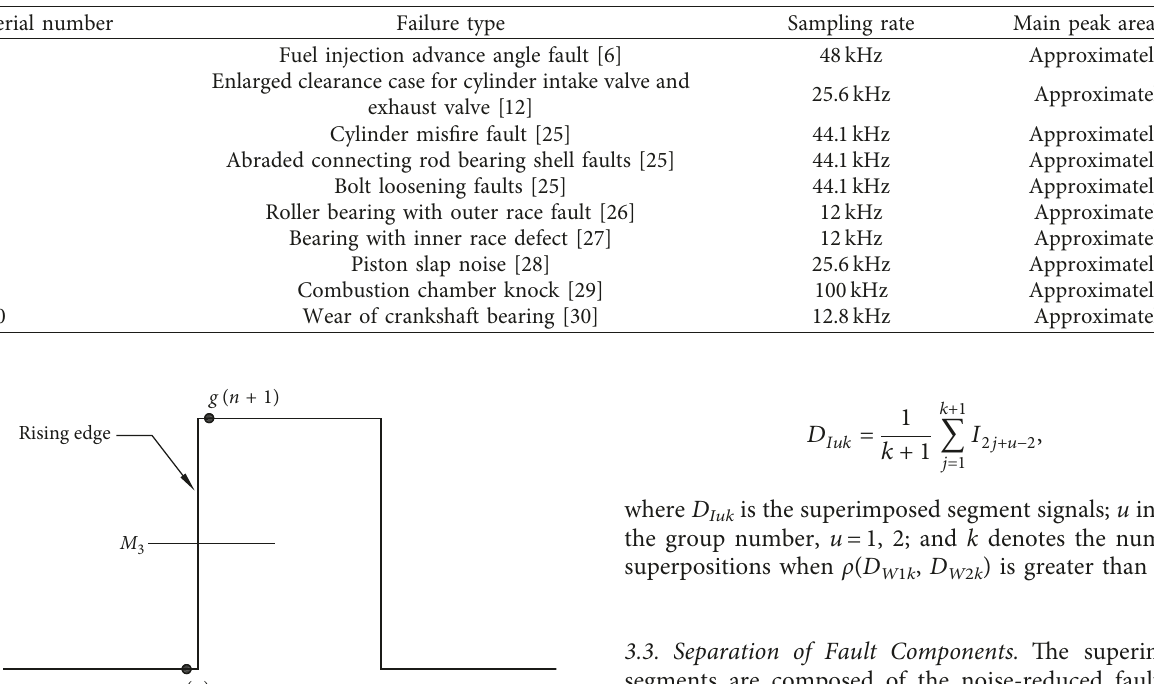
n 1 is larger than M 3 , a rising edge is considered to ( + )